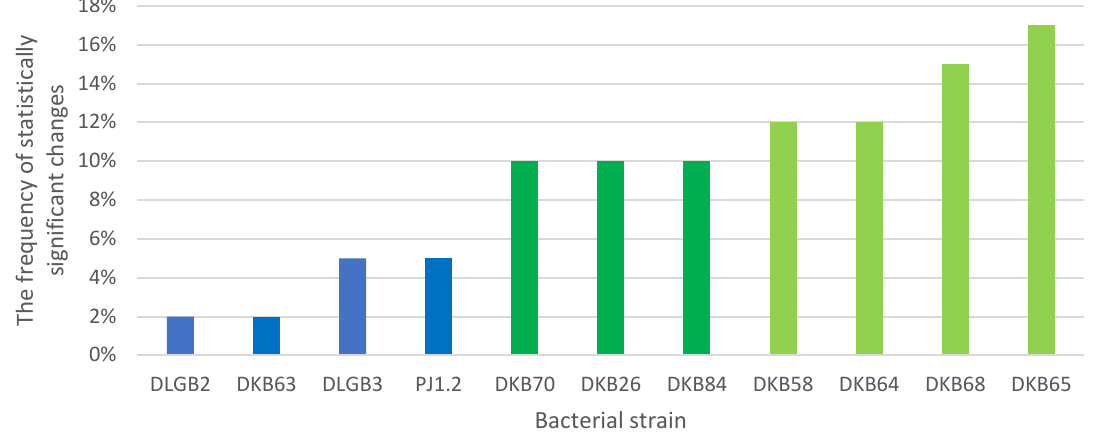
Figure 2. Frequency of statistically significant changes in the indices of chlorophyll “a” fluorescence in strawberry as a result of inoculation with rhizosphere bacteria, between optimal soil moisture and water deficit conditions.